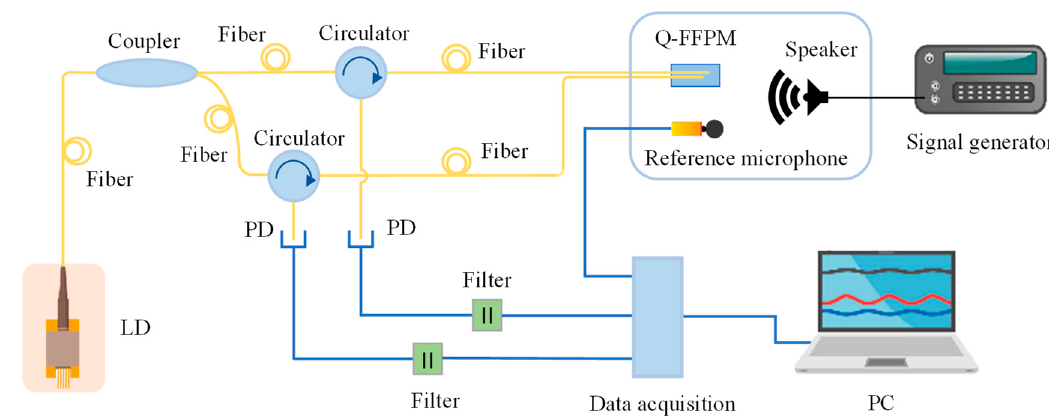
Figure 10. Q–FFPC–DCM experimental system composition diagram.